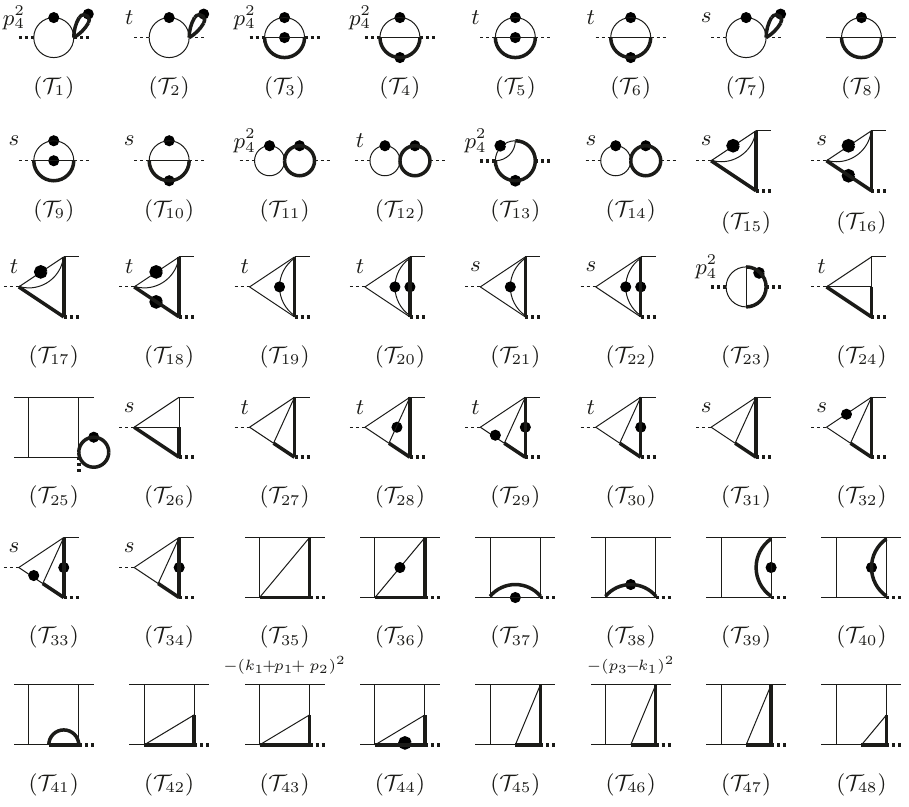
Figure 2 . Master integrals in pre-canonical form. Internal plain thin lines represent massless propagators, while thick lines represent the vector-boson propagator. External plain thin lines represent massless particles on their mass-shell. External dashed thin lines represent the dependence on s , t , or m 2 H . The external dashed thick line represents the Higgs on its